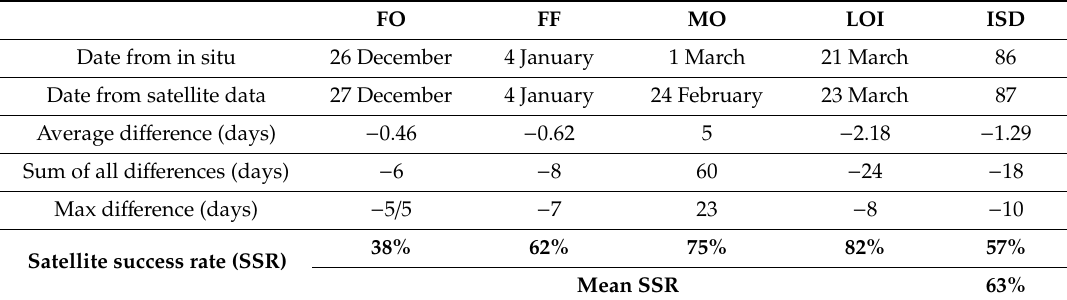
Table 3. Statistics in defining the timing of the key stages of the ice formation in the Curonian Lagoon from the satellite observations and coastal records. FO FF MO LOI ISD Date from in situ 26 December 4 January 86 Date from satellite data 27 December 4 January 24 February 23 March 87 Average di ff erence (days) − 0.46 − 0.62 5 − 18 Max di ff erence (days) − 5 / 5 − 7 23 − 8 − 10 38% 62% 75% 82% 57% Satellite success rate (SSR) Mean SSR